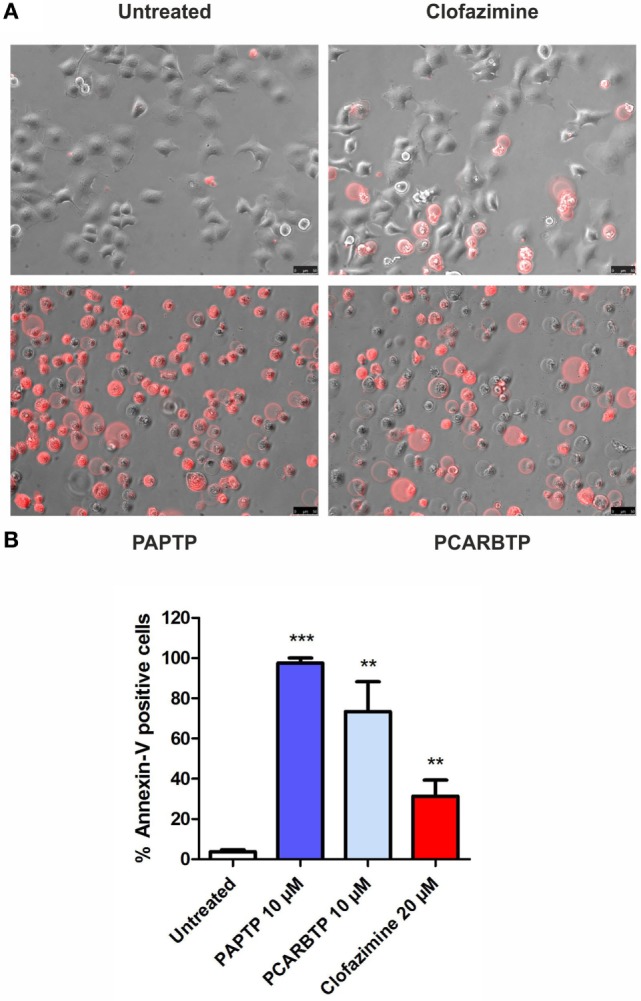
Inhibition of mitochondrial Kv1.3 kills PANC-1 cells. (A) PANC-1 cells were treated or left untreated with different membrane permeant Kv1.3 inhibitors (PAPTP 10 µM, PCARBTP 10 µM, and clofazimine 20 µM) for 24 h. Cell death was determined by staining with an Alexa568 coupled Annexin V by fluorescent microscopy. The images are representative of three different replicates. (B) Quantification of Annexin V-positive cells from the experiments shown in (A): represented is the percentage of Annexin V-positive cells ± SEM (n = 3; **p < 0.01; ***p < 0.001).